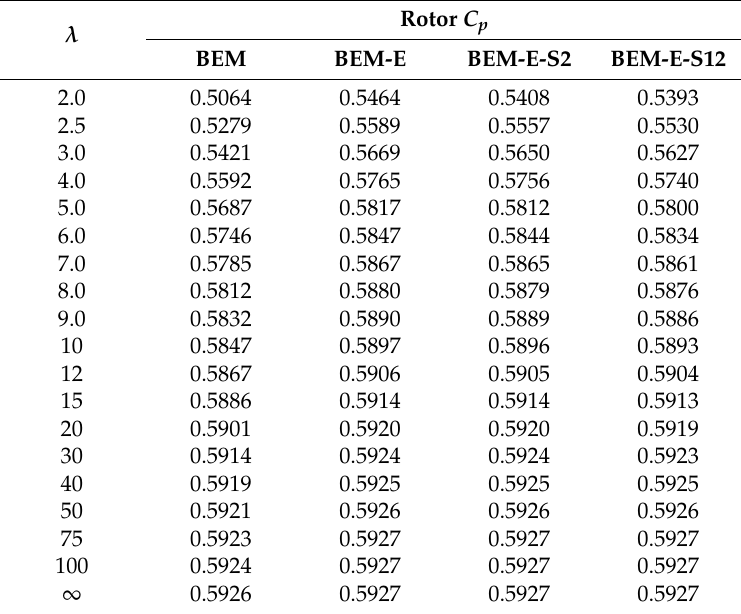
Table 2. C p − rotor comparisons for the BEM